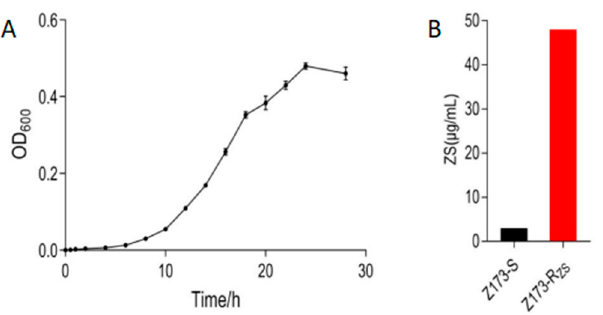
Figure 1. Phenotype of Z173-S and Z173-R ZS . ( A ) The growth curve of Z173-S. ( B ) The minimum inhibitory concentration of Z173-S and Z173-R ZS . Results are displayed as mean ± SD. At least three biological repeats were carried out.